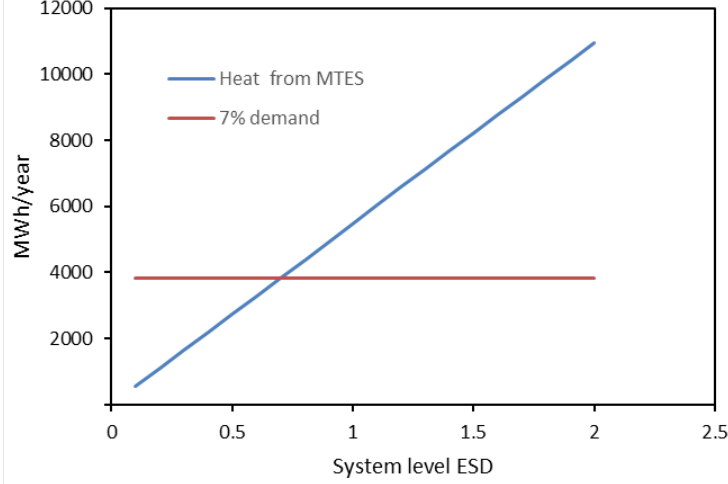
Figure 3. M-TES system energy storage density (ESD) required to achieve 7% of the City of Surrey’s 2022 target.